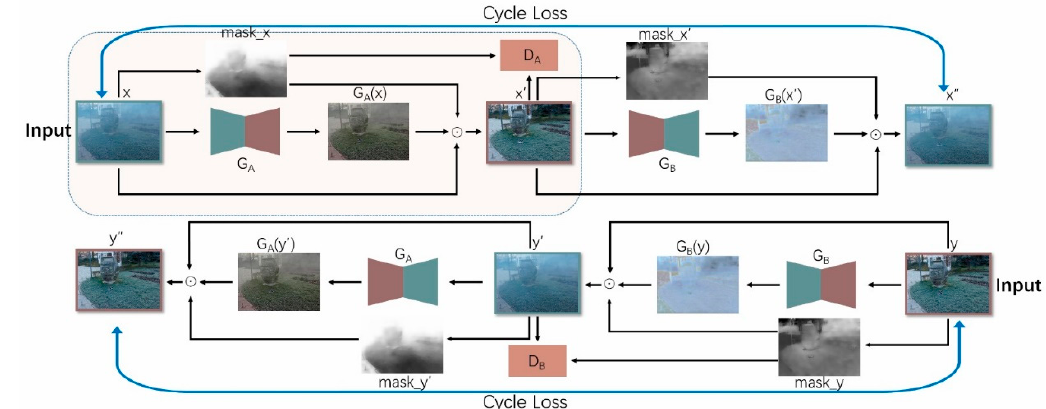
Figure 3. The structure of the proposed network and the intermediate process of image conversion.